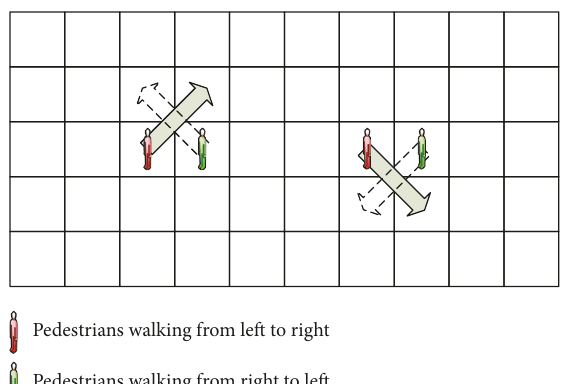
Pedestrians walking from left to right Pedestrians walking from right to left Figure 5: Collisions when pedestrians move